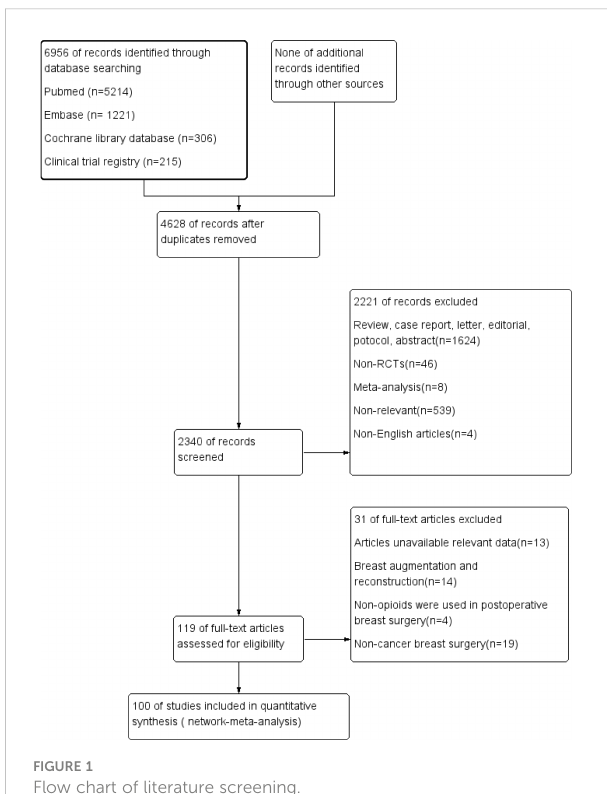
FIGURE 1 Flow chart of literature